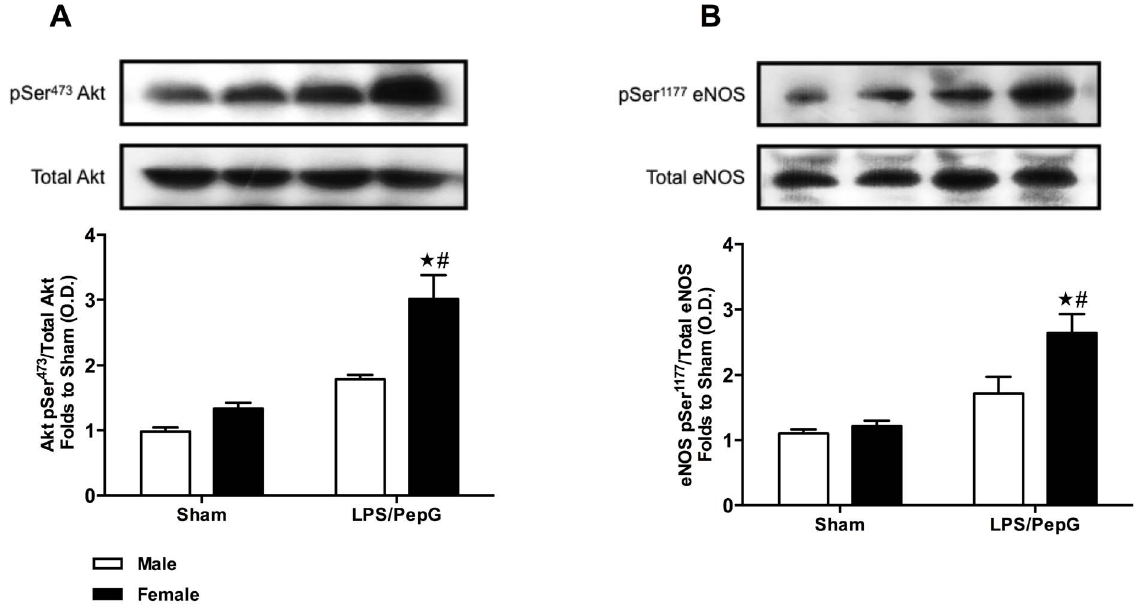
Figure 2. Gender dimorphism of the phosphorylation of Akt and eNOS in the hearts of mice subjected to LPS (3 mg/kg)/PepG (0.1 mg/kg) co-administration. Male or female mice received either LPS (3 mg/kg)/PepG (0.1 mg/kg) or PBS. Signalling events in heart tissue were assessed at 18 hours. Densitometric analysis of the bands is expressed as relative optical density (O.D.) of ( A ) phosphorylated Akt (pSer 473 ) corrected for the corresponding total Akt content and normalized using the related sham band; ( B ) phosphorylated eNOS (pSer 1177 ), corrected for the corresponding total eNOS content and normalized using the related sham band. Each analysis ( A–B ) is from a single experiment and is representative of three to four separate experiments. Data are expressed as means 6 SEM for n number of observations. w P , 0.05 versus the respective sham group, # P , 0.05 versus male LPS/PepG group.